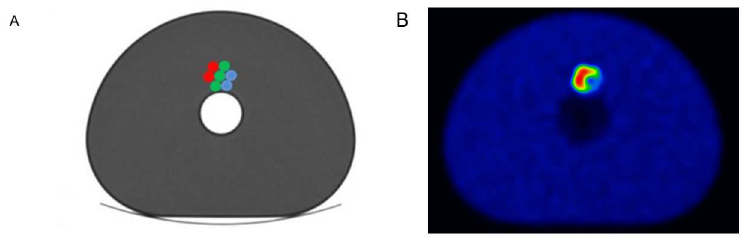
Fig 2. Revolver insert placed in the NEMA IQ Phantom. Illustrative schematic layout, (A) and a representative slice of the attenuation corrected PET image